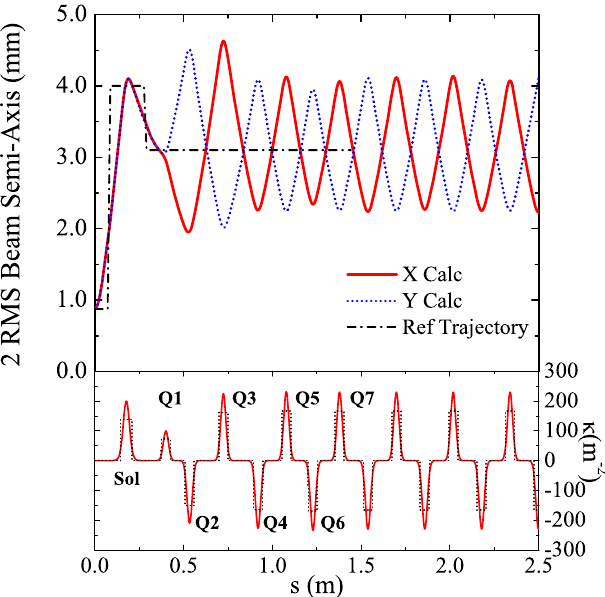
(cid:5) FIG. 9. (Color) UMER RMS-envelope matching with a short 0 solenoid and seven PC quadrupoles (the periodic lattice starts at Q7). Electron beam parameters are: 7.2 mA, 10 keV, and (cid:4) (cid:5) (cid:5) 72 : 92 (cid:12) (from SPOT ). 16 (cid:10) m . Envelope calculations for (cid:5) 0 The use of the ‘‘reference trajectory’’ for matching is explained in the Appendix. One transverse component of the focusing function is shown at the bottom, including the equivalent hard- edge function (see also third column in Table